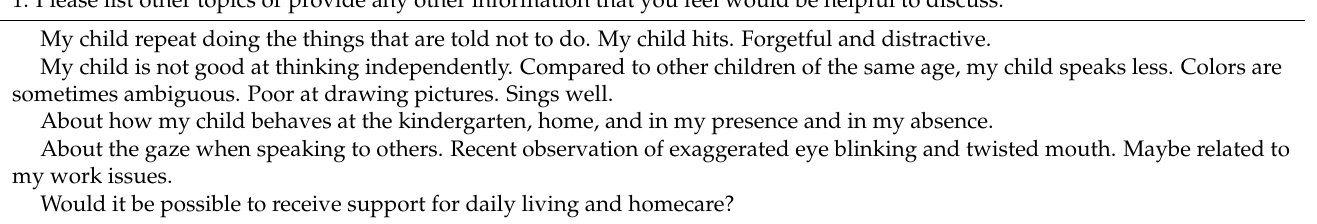
Table 2. Answers to the open ended questions of the Family Needs